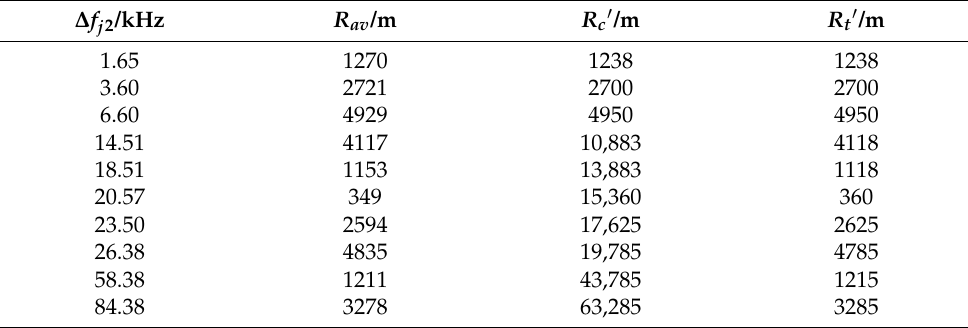
Table 6. Measured and theoretical data under different frequency